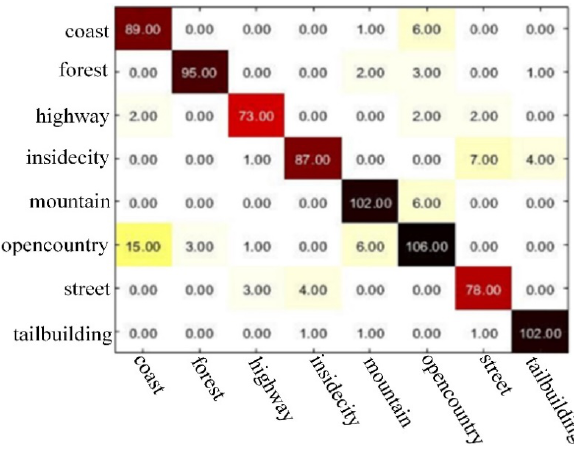
Figure 10. The visual predicted matrix of Labelme.